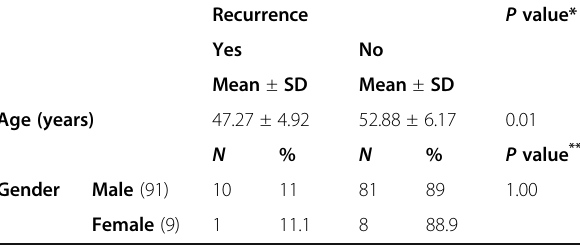
Table 1 The relation between the demographic data and HCC recurrence Recurrence P value*